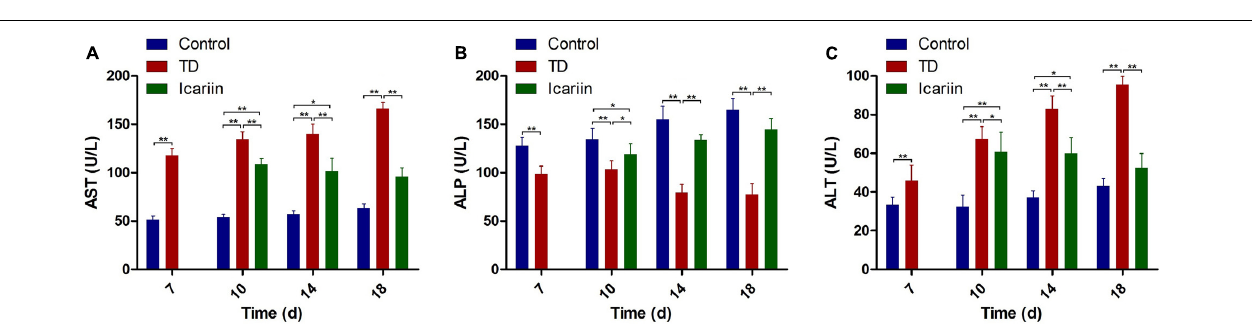
FIGURE 6 | H&E stained histopathology of epiphyseal tibial growth plate (GP). (A1,A2) The normal GP exhibits regular columns of cells surrounded by blood vessels in proliferative and hypertrophic zone. (B1,B2) Necrosis and reduced number of blood vessels and avascularized GP in thiram-fed birds in TD group. (C1,C2) Restored angiogenesis in proliferative and hypertrophic zones of growth plate shown in icariin group. Arrows indicate blood vessels.